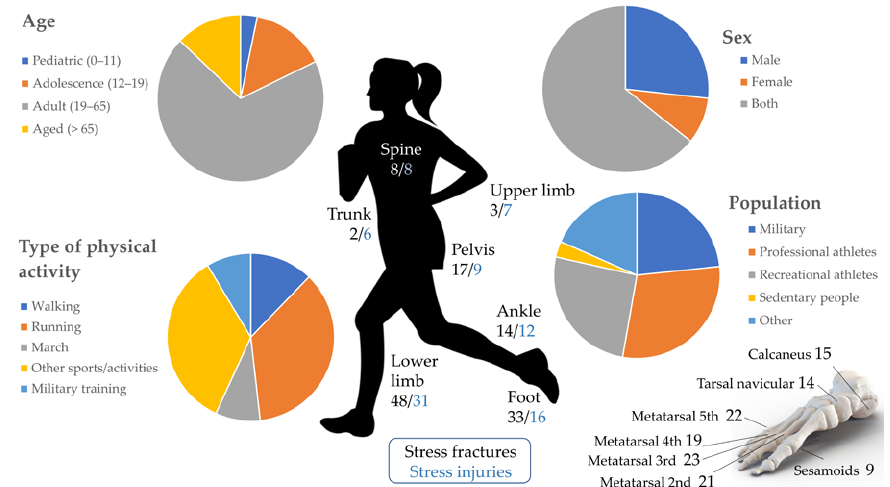
Figure 2. Epidemiology of the reviewed articles regarding age, sex, type of physical activity, population, and location of stress injuries and stress